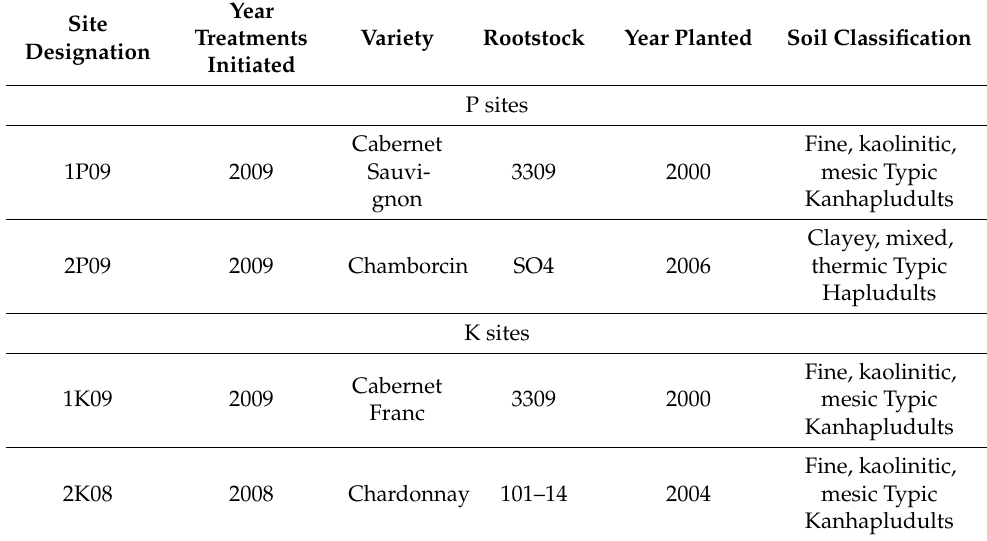
Table 9. Description of sites used in the P and K response studies